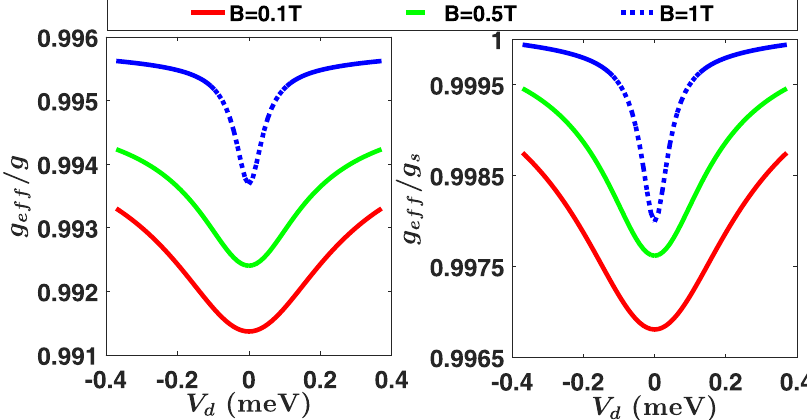
Figure 8. The DQD effective g -factor g eff as a function of the applied electric and magnetic field. The left panel gives the ratio of g eff over the bulk value, while the right panel is the ratio of g eff over the effective g -factor g s of a single